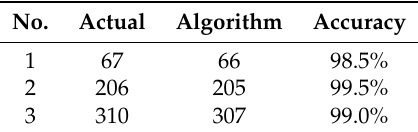
Table 1. Results of the step